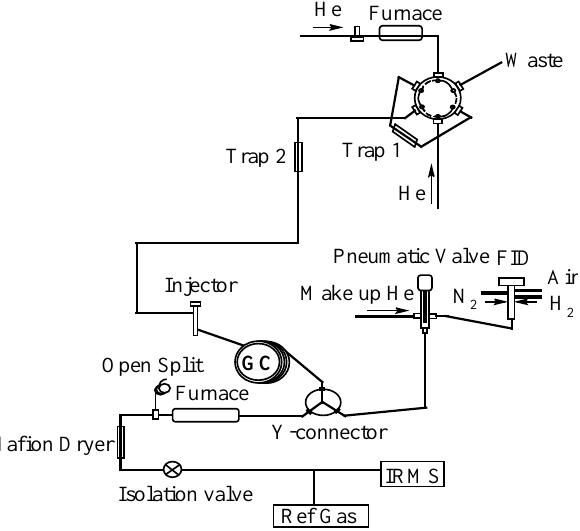
Figure 1. Schematic diagram of the two-stage preconcentration sys-